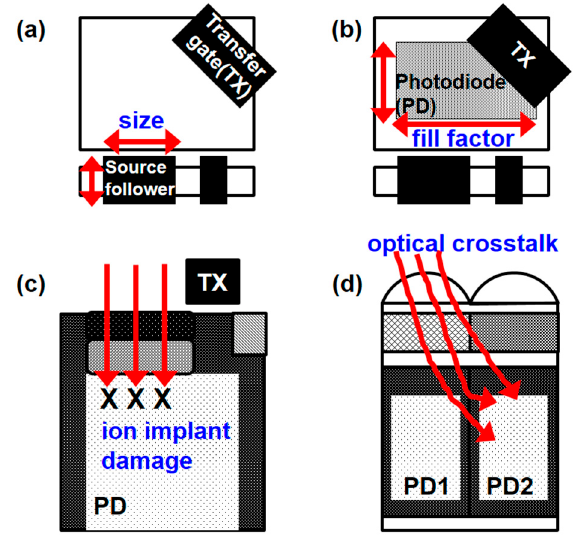
Figure 1. Challenges in submicron pixel generation. ( a ) Top view of pixel layout highlights the small size source follower; ( b ) top view of pixel layout indicating the small fill factor; ( c ) cross-sectional view of pixel depicting high ion implant damage induced by the high dose photodiode; ( d ) cross-sectional view of pixel showing high optical crosstalk.